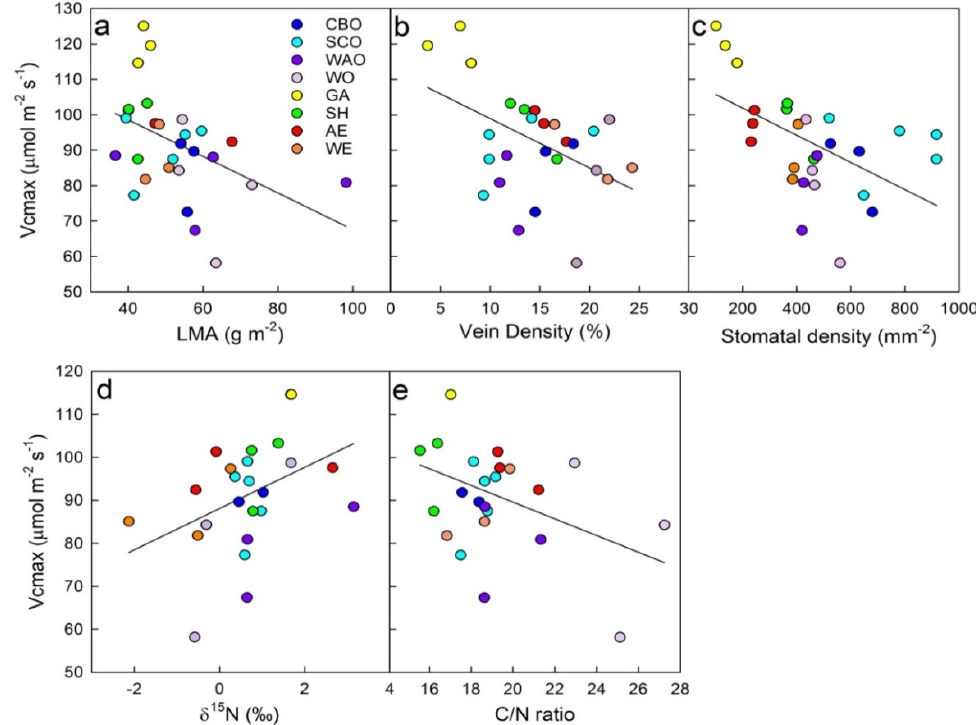
Figure 1. Significant correlations between Rubisco-limited carboxylation rate (V Cmax ; µ mol m − 2 s − 1 ) and leaf parameters including ( a ) leaf mass per unit area (LMA; g m − 2 ), ( b ) vein density (%), ( c ) stomatal density (mm − 2 ), ( d ) δ 15 N (% (cid:24) ), and ( e ) C / N ratio. Dark blue circles = cherrybark oak (CBO), light blue circles = swamp chestnut oak (SCO), dark purple circles = water oak (WAO), light purple circles = willow oak (WO), yellow circles = green ash (GA) green circles = shagbark hickory (SH), red circles = American elm (AE), orange circles = winged elm (WE).